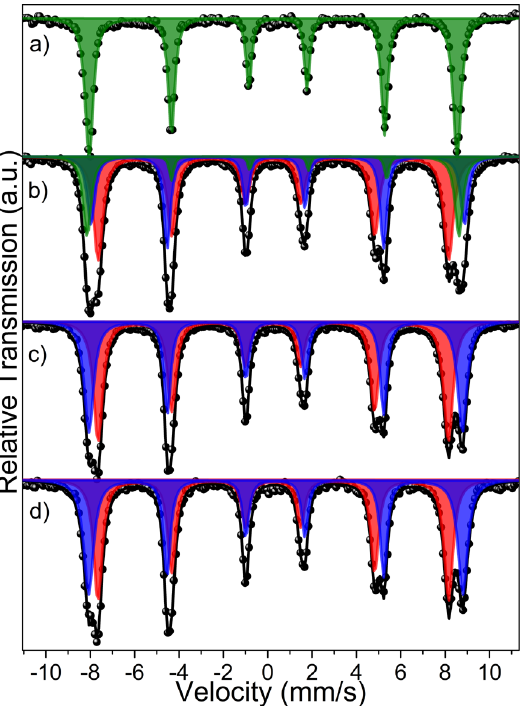
Figure 3. Mössbauer spectra of (a) the initial mixture of reactants and of the samples submitted to heat treatments at (b) 1000 ºC,